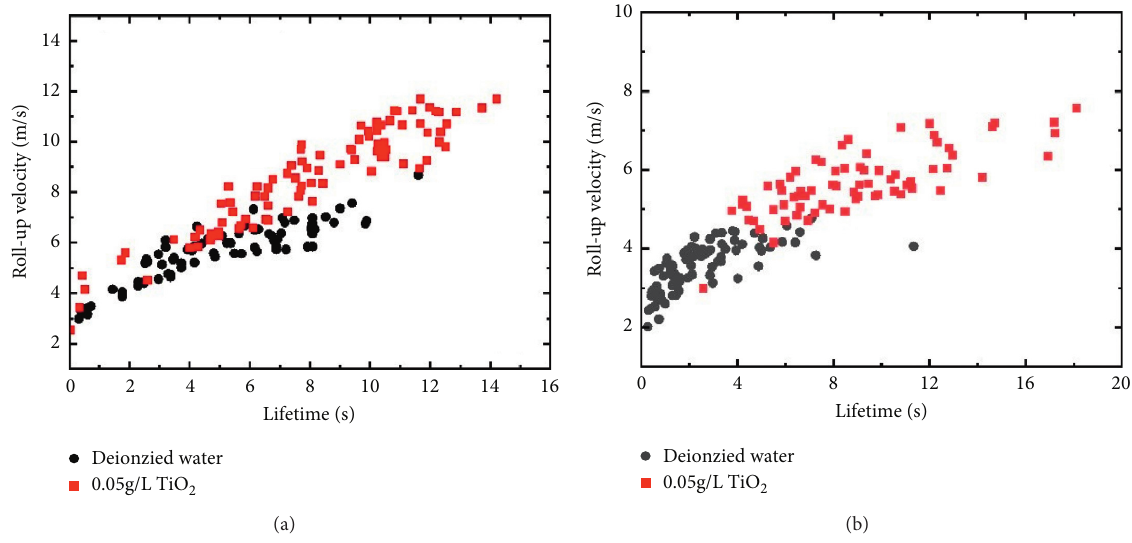
Figure 20: Correspondence of bubble roll-up velocity and bubble lifetime in different liquid environments: (a) T